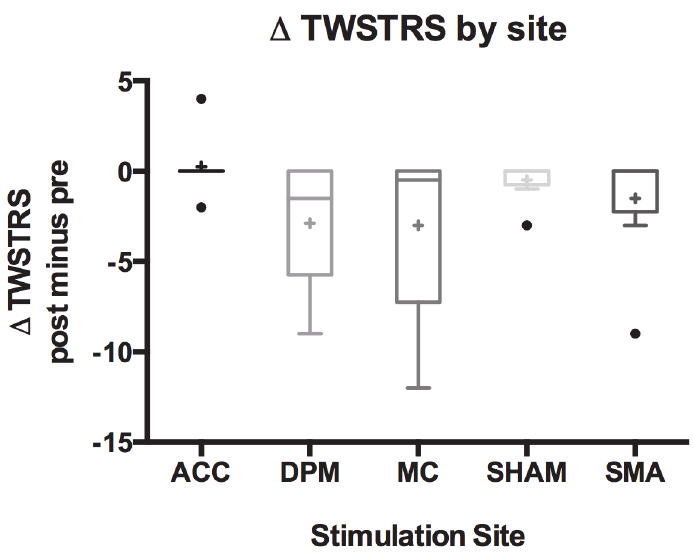
Fig 3. Boxplots of change in TWSTRS severity score by stimulation site showing greatest improvement over dPM and MC. A box in the boxplot represents first quartile to the third quartile with the median as the centerline. The outliers are represented by circles and the mean value as a cross. Note that the ACC boxplot is collapsed since the first quartile is equal to the third quartile